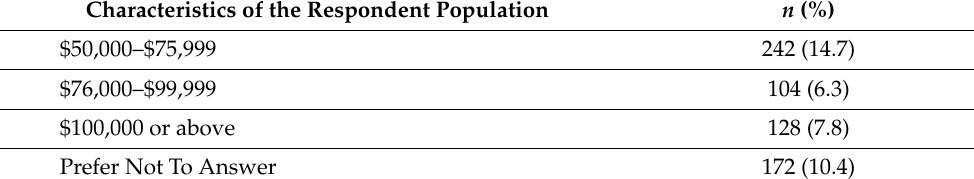
Table 1. Cont. Characteristics of the Respondent